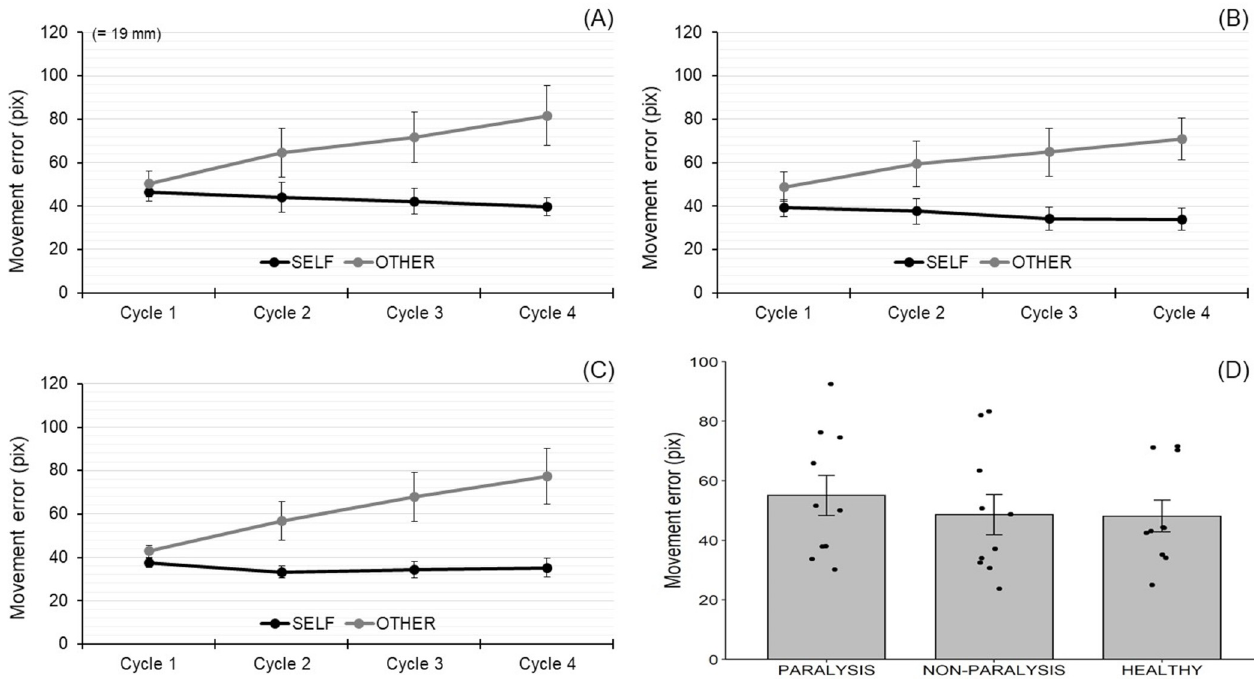
Fig 3. Movement error for paretic upper limb (A), non-paralyzed upper limb (B), healthy elderly individuals (C), and groups (D). For each group, the average of movement errors between the SELF and OTHER conditions and among all cycles was calculated (D). Error bars indicate standard errors.